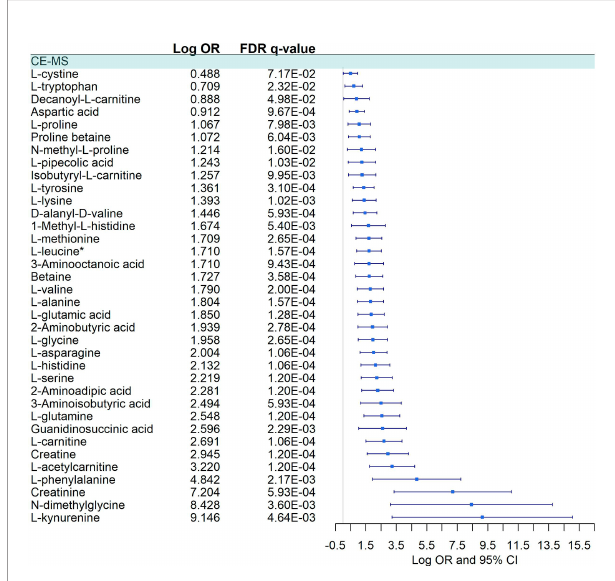
FIGURE 3 | Pairwise comparison of CE-MS metabolites between COVID-19+ patients and COVID -. Statistics: Logistic regression adjusted for age and sex was used. The False Discovery Rate or FDR was used to cope with multiple testing, and q-values are provided. L-leucine*: